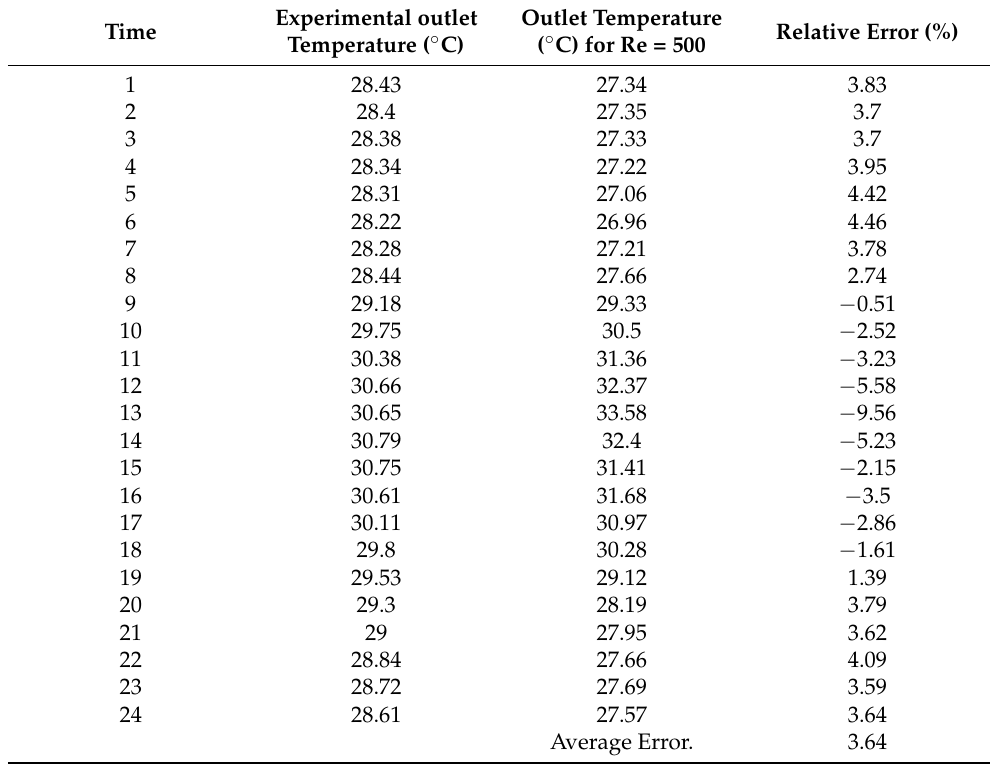
Table 8. Comparison of experimental vs. modeled outlet temperature for 9 August 2016 (2 m depth). Experimental Time